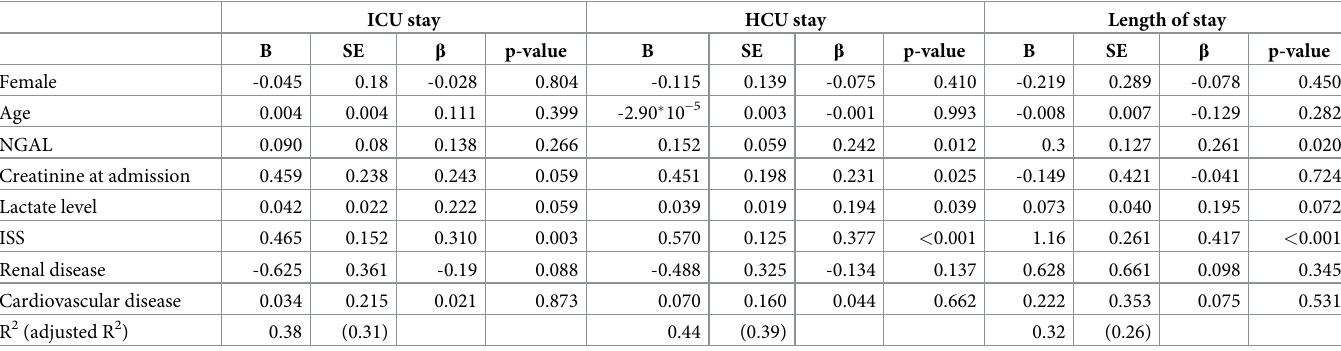
Table 2. Factors and NGAL related to